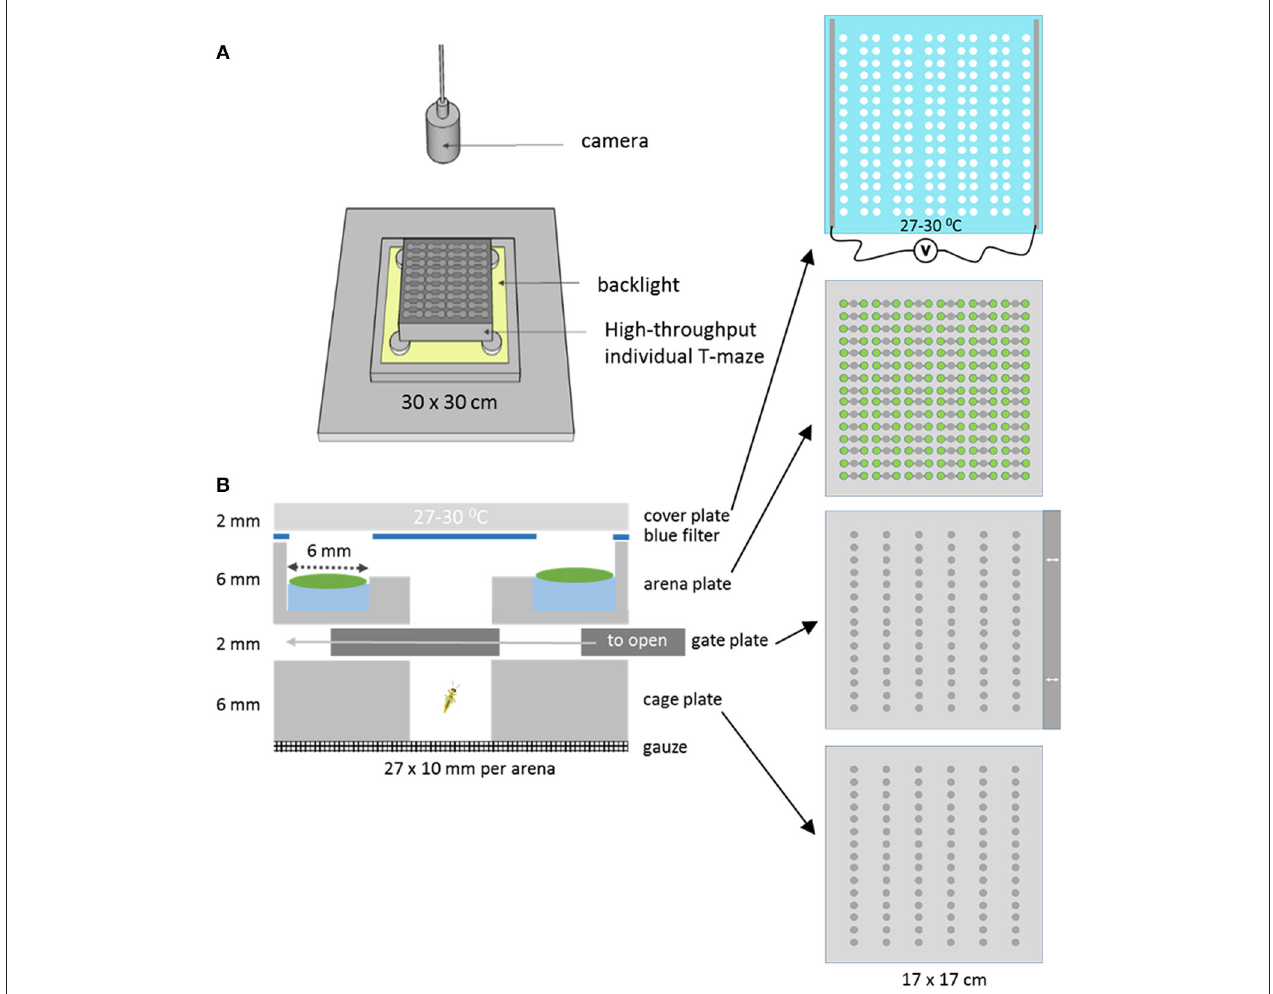
FIGURE 1 | The T-maze array set up. (A) The T-maze array consisted of stacked layers of Perspex plates topped with a heated glass cover. It was lit from below with a backlight and monitored from above with a camera. (B) Cross section of one single T-maze arena of the complete array of 90. The bottom compartment of a cage plate closed with a gate plate, that could create access to the arena plate by sliding it to the left. The T-maze arena consisted of two leaf disk zones with disks placed on 20 µ l water, a blue filter with holes in the position of the leaf discs, and a heated cover plate made of